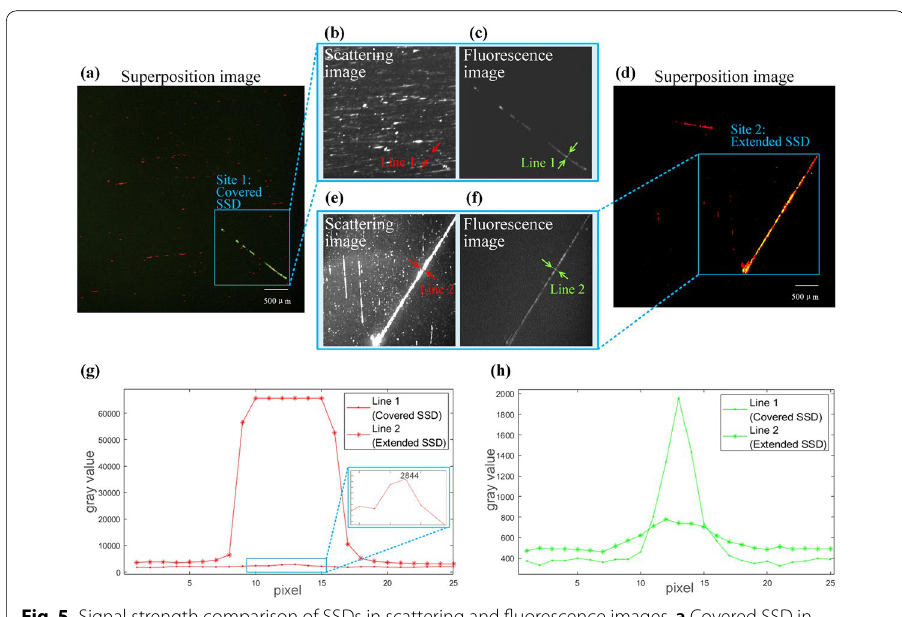
Fig. 5 Signal strength comparison of SSDs in scattering and fluorescence images. a Covered SSD in superposition image. b c Locally enlarged scattering and fluorescence images (contrast stretched from original to show). d Extended SSD in superposition image. e f Locally enlarged scattering and fluorescence images (contrast stretched from original to show). g Contrast of the gray values of the two defects in scattering image (the sampling lines are the connection lines of the red arrows in Fig. 5b and Fig. 5e). h Contrast of the gray values of the two defects in fluorescence image (the sampling lines are the connection lines of the green arrows in Fig. 5c and Fig.